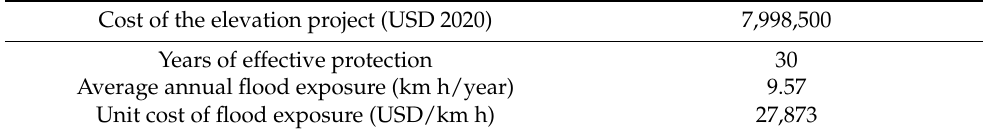
Table 8. Values informing the unit cost of flood exposure.